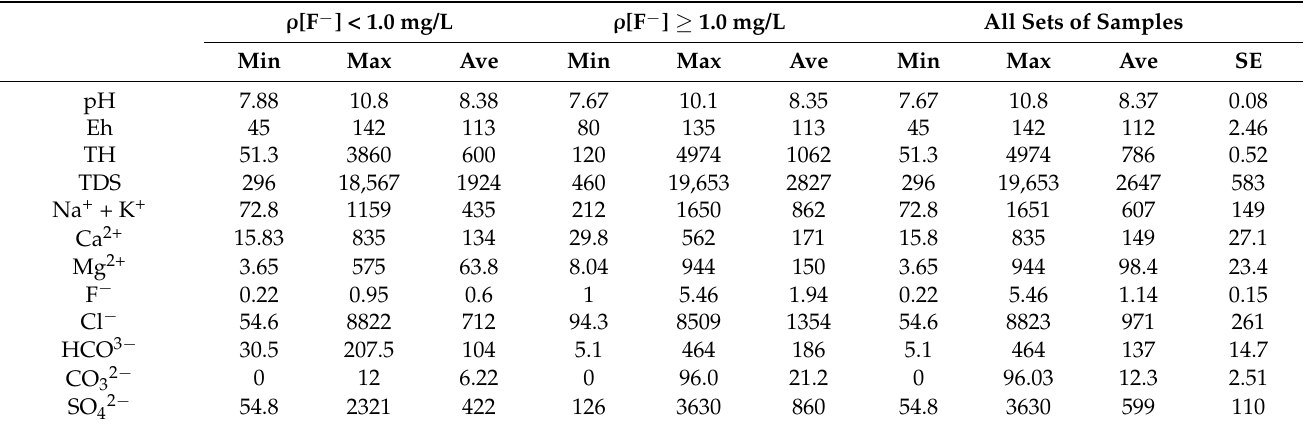
Table 1. Statistical table of the hydrochemical parameters of the samples for different types of